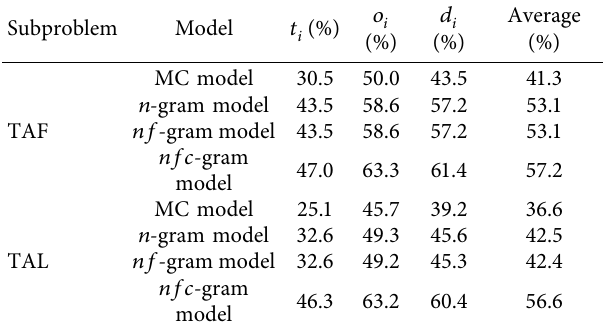
Table 4: The average prediction accuracy rates of different models.